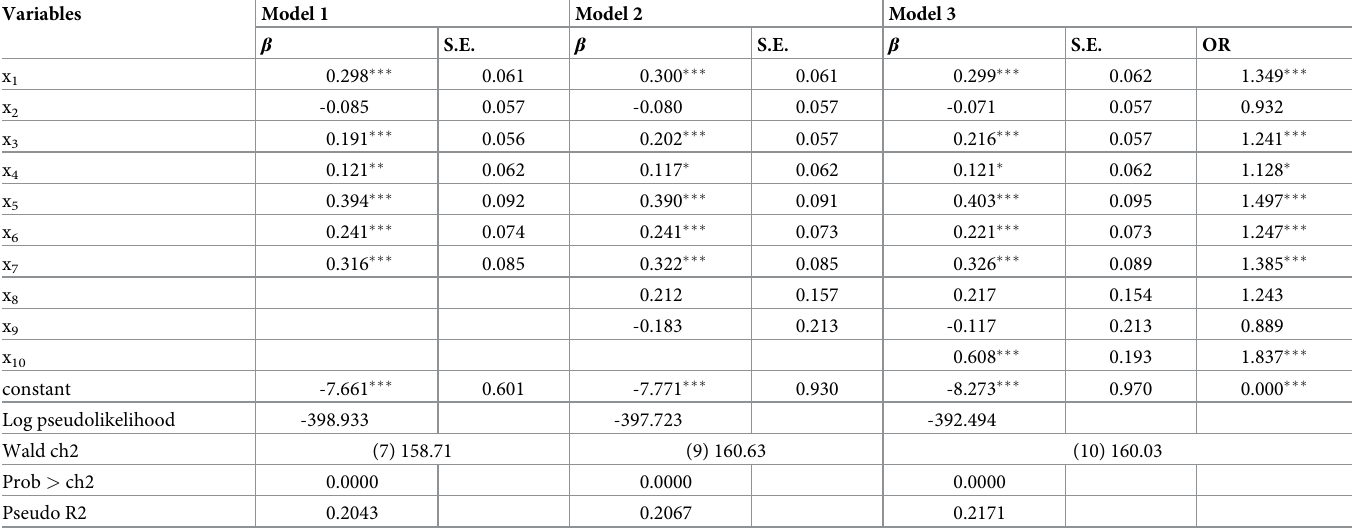
Table 5. Logistic regression for product